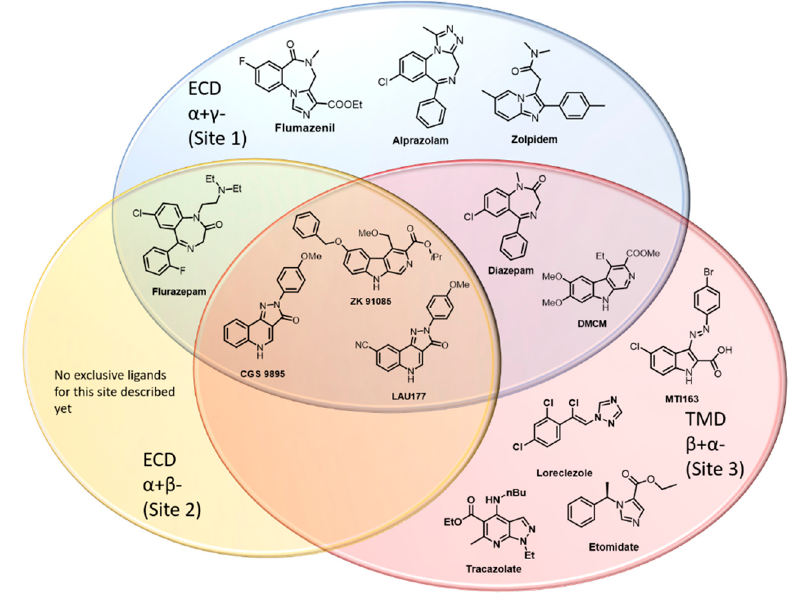
Figure 6. Graphical overview of chemical scaffolds which bind to distinctive interfaces at αβγ GABA A receptors. The three binding sites are depicted as colored ellipses: site 1, ECD- α +/ γ− : blue; site 2, ECD- α +/ β− : orange; site 3, TMD- β +/ α− red. Substances that bind at more than one site are placed at the intersection of the different binding sites. All placements rest on current evidence from structural studies [4,17] and decades of mutational studies [19–21,23–26]. Some of the placements are thus tentative. Of note, for both the benzodiazepine site and the “etomidate site”, many more ligands have been described, partly reviewed by Sieghart (2015) and Sieghart and Savic (2018) [1,10]; however, low affinity interactions with other sites have not been regularly investigated.